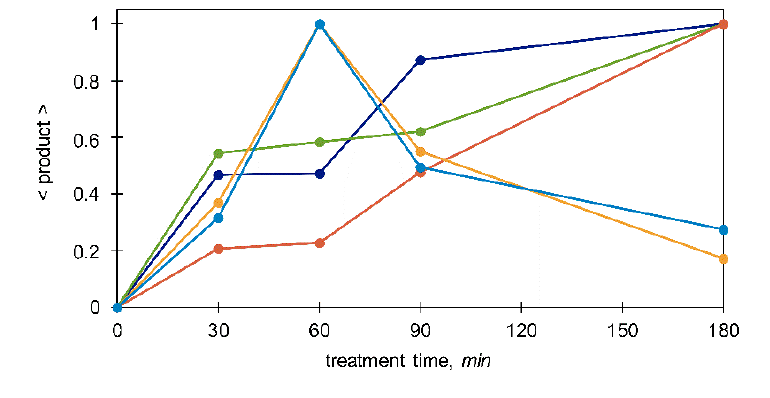
Figure 7. Normalized relative amount of chosen products (see Equation (4) in Section 2.4) in ozonated 2,4-dichlorophenol (DCP) (50 mg/L) determined by SPME/GC–MS.